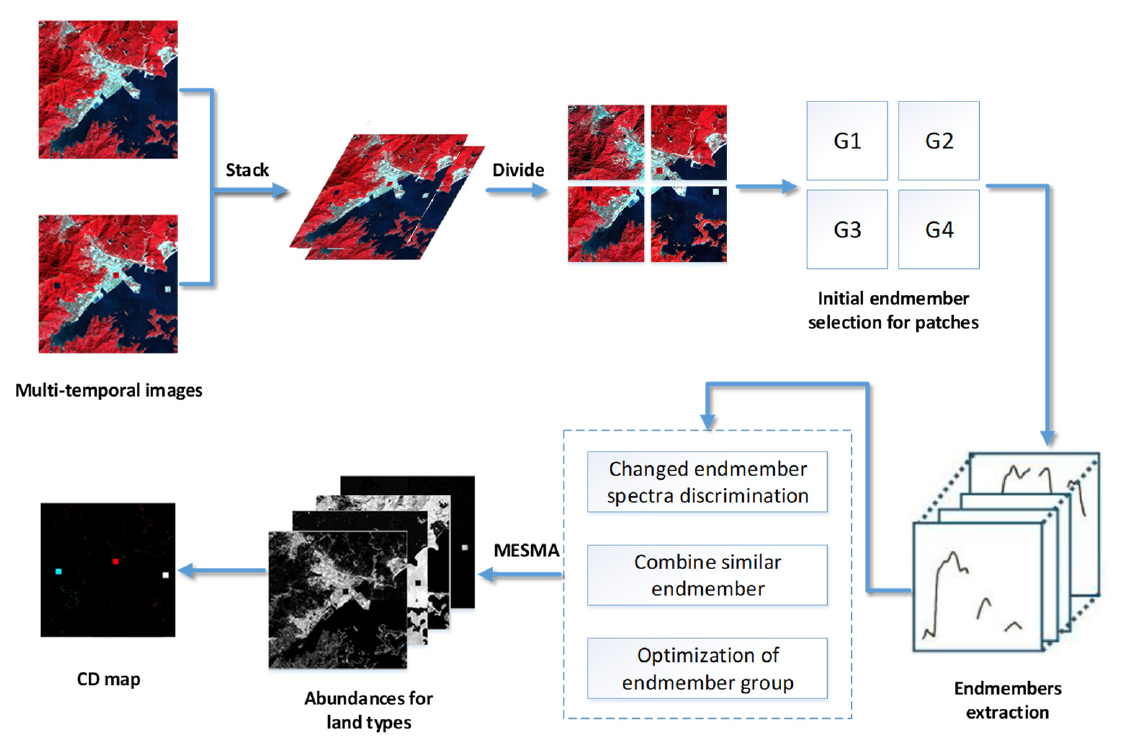
Figure 3. The process of the CD_SDSUVE methodology.